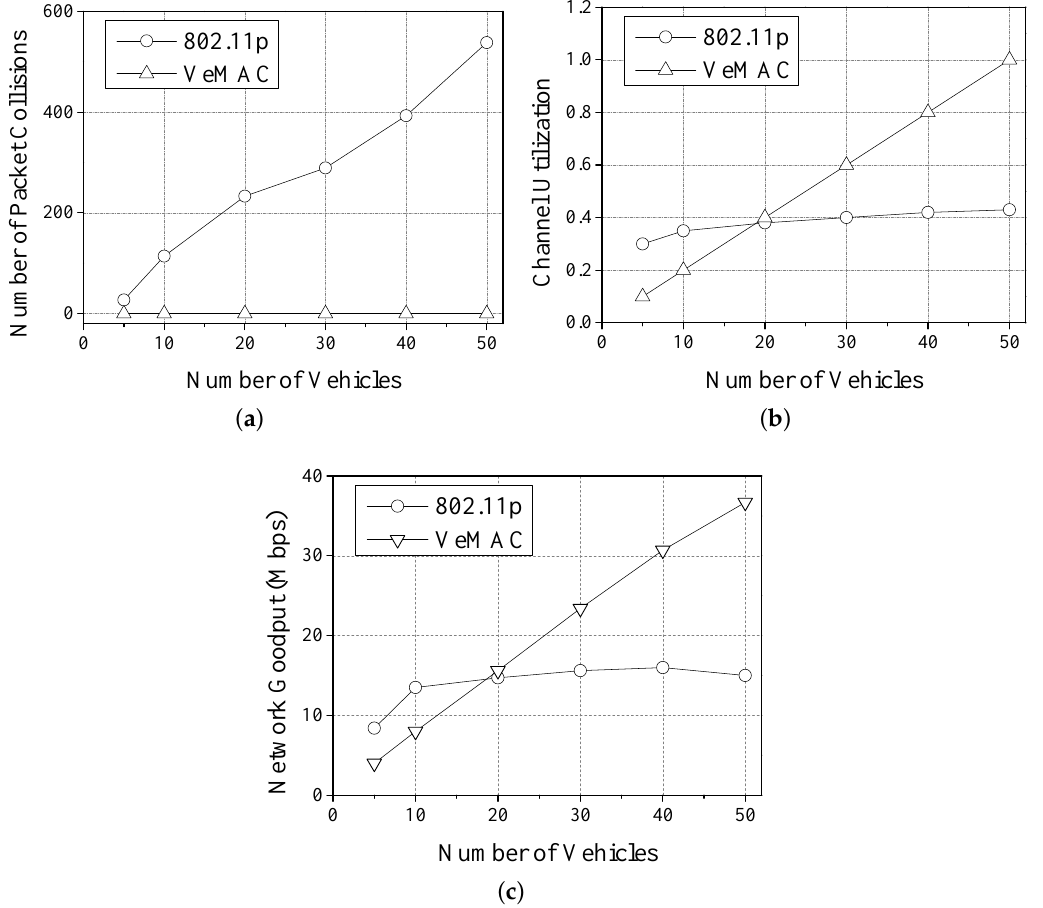
Figure 1. Comparison of IEEE 802.11p and VeMAC with different numbers of vehicles. ( a ) Packet collision; ( b ) Channel utilization; ( c ) Network